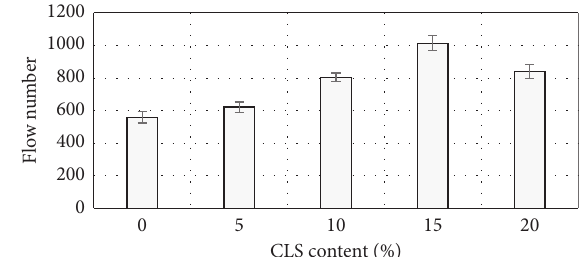
Figure 9: Flow number of asphalt mixtures.